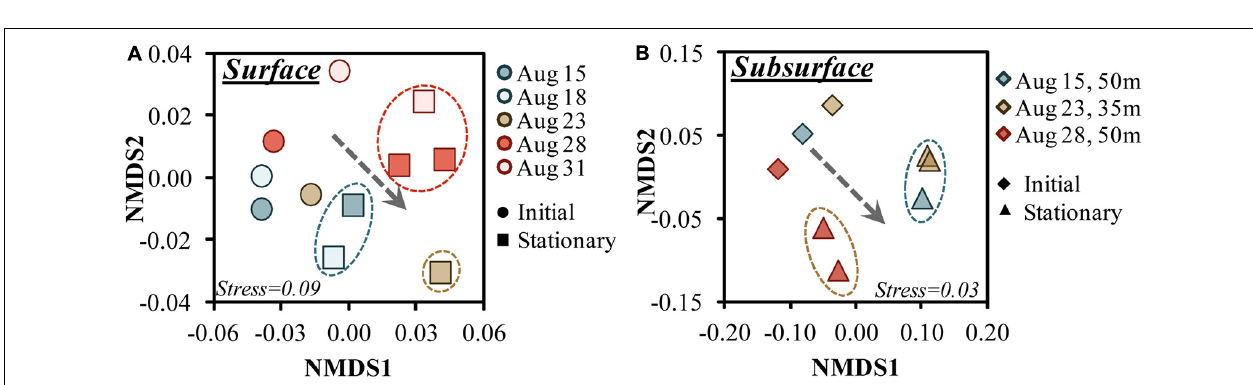
FIGURE 4 | Stacked bar plot of top 50 most abundant genera determined on 16S rDNA amplicons as observed at the initial condition of the OM remineralization experiments. Both family and genus level names are included in the legend, where available.